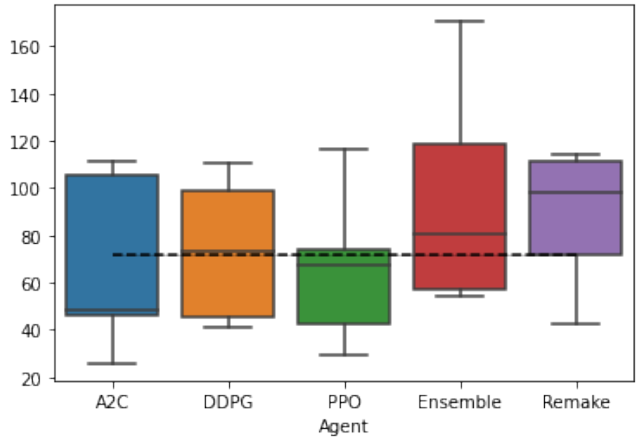
Figure 5. Cumulative returns of each agent with the average return of the top 30 JPX stocks (the dotted line is the benchmark index, which is the cumulative return of the